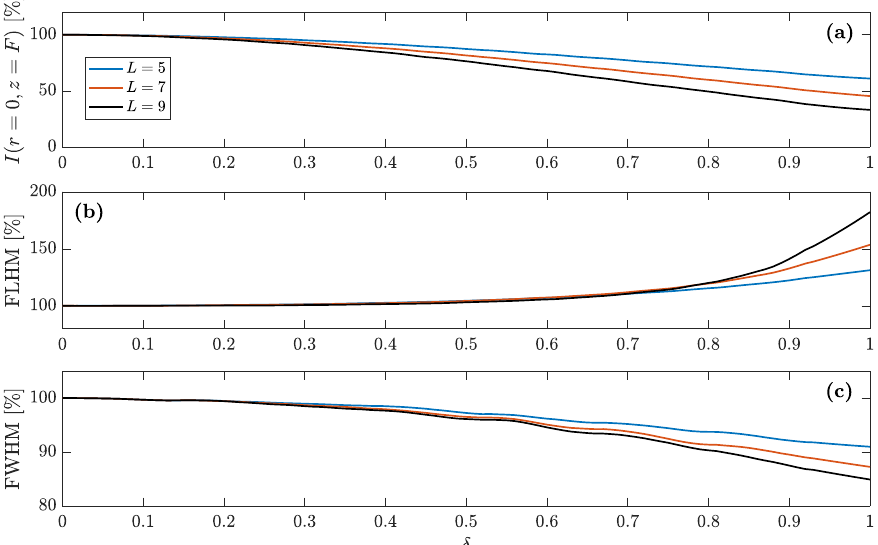
Figure 5. Effects of predistortion on: ( a ) focal intensity peak, ( b ) focal depth, and ( c ) lateral resolution. The L parameter stands for the number of inner regions where predistortion is applied.